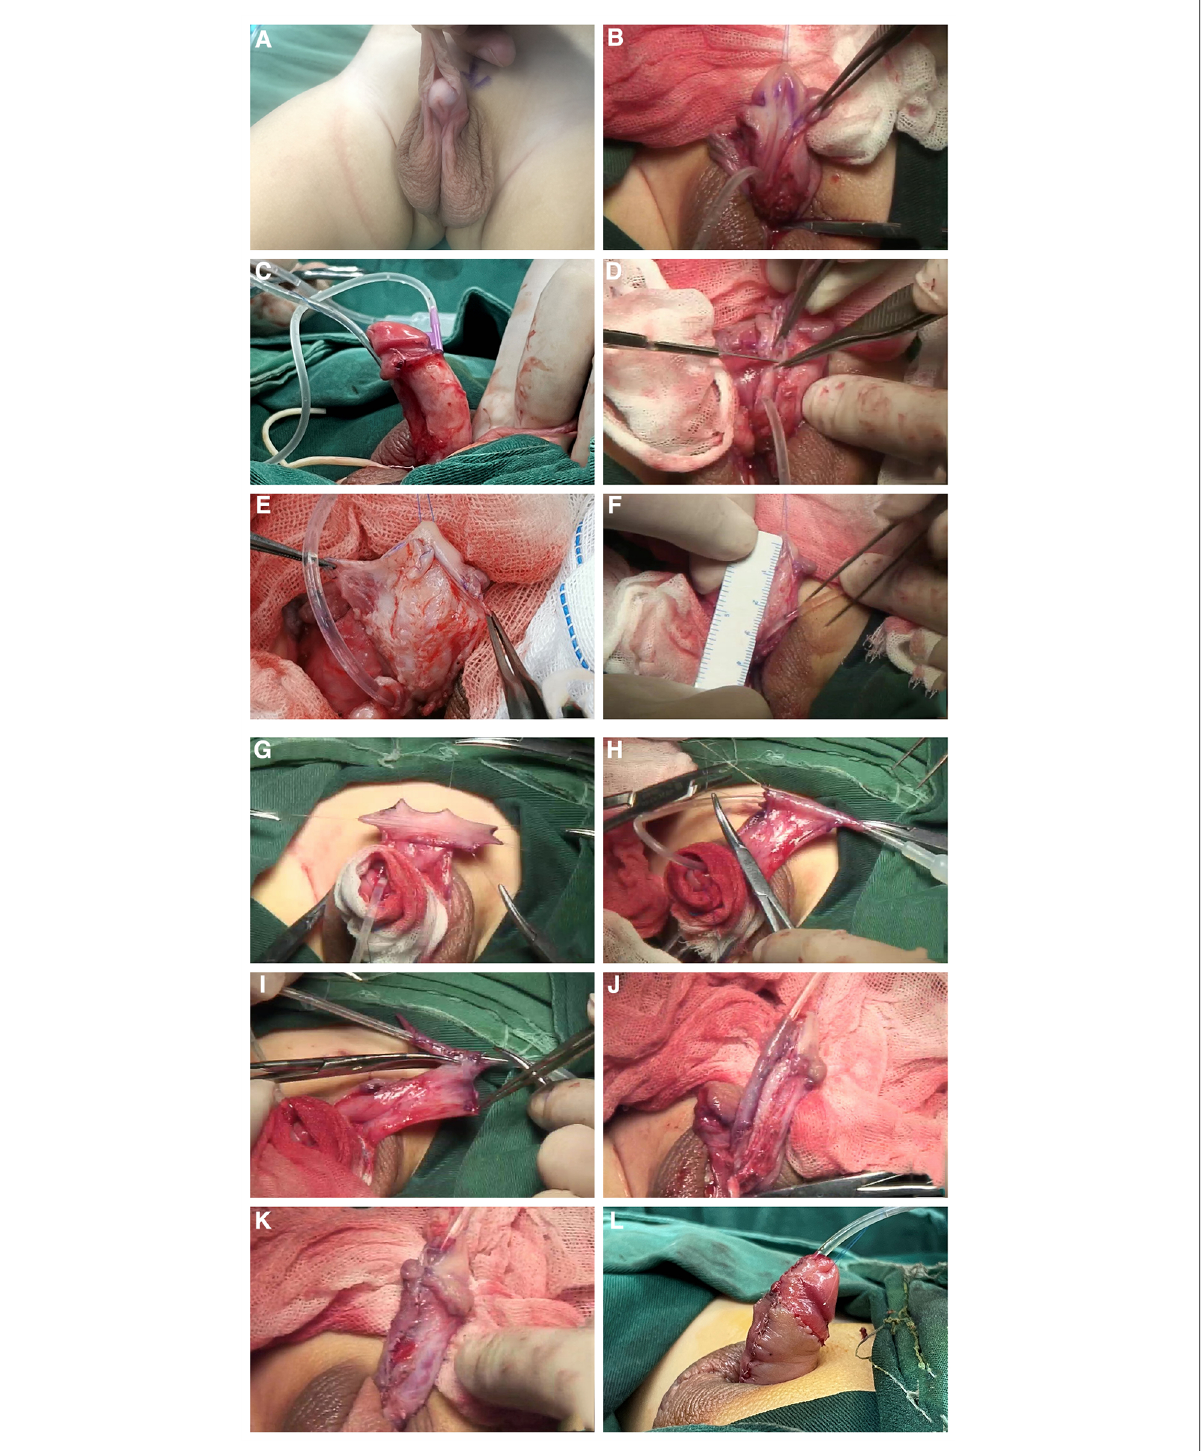
FIGURE 2 ( A ) Pre-surgery appearance. ( B – E ) The prepuce was completely degloved. Buck ’ s fascia on both sides of the urethral plate was carefully separated, the ventral urethral plate was incised transversely in the middle and separated to two parts. ( F – I ) A fusiform fl ap which was longer than required was dissected on the dorsal prepuce. the middle part was rolled and sutured to a tube shape, then the vascular pedicle of the fl ap was excised. ( J ) The resulting free graft was anastomosed to the separated urethra plate with interrupted sutures. ( K ) The Buck ’ s fascia together with the divergent spongiosum and the glans wings were sutured at the midline to completely cover the neo urethra. ( L ) Post-surgery